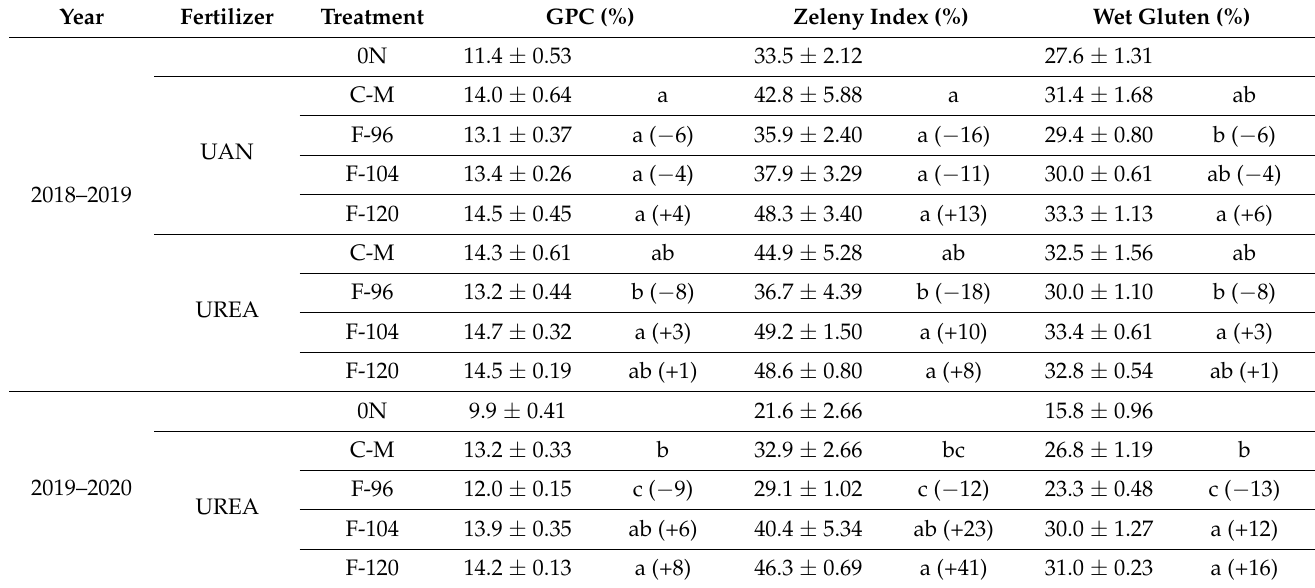
Table 4. Grain quality parameters: grain protein content (GPC), Zeleny index and wet gluten content (mean ± S.E.; n = 3) in Triticum aestivum L. under different foliar N fertilization treatments in a two-year field trial with UAN and urea fertilizers. In brackets: % variation vs. each conventional management C-M. Letters: statistical comparisons among treatments within same fertilizer (Newman–Keuls test, p ≤